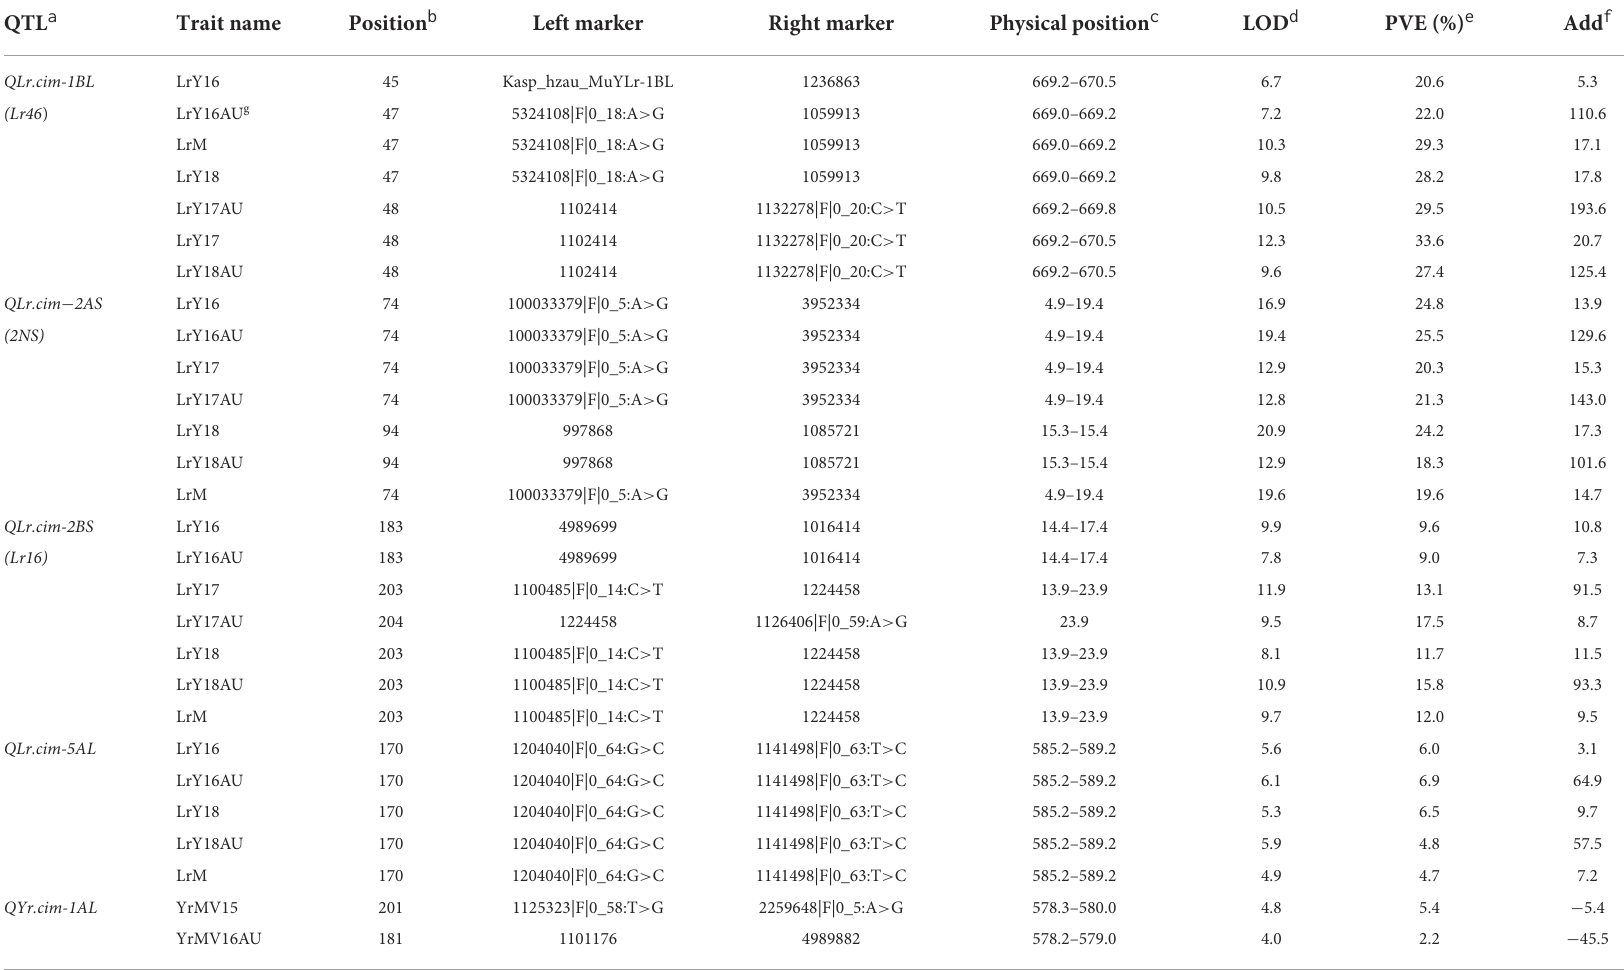
TABLE 2 Position and effects of quantitative trait loci (QTL) for adult plant resistance (APR) to stripe rust, leaf rust, and mean of final stripe and leaf rust severities over all tested environments (YrM and LrM), using inclusive composite interval mapping (ICIM) by IciMapping 4.2 in the 138 Apav#1 × Mucuy F 5 RIL